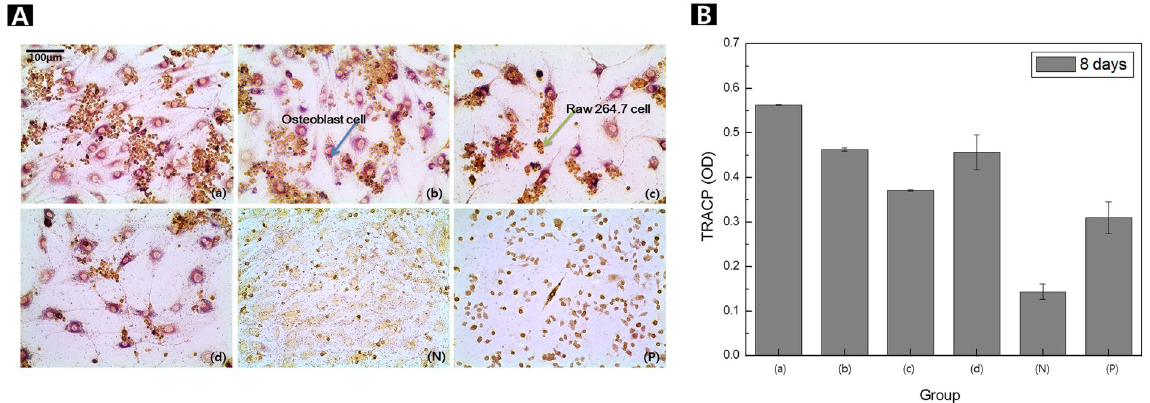
Figure 7. TRAP staining assay results ( A ) and TRACP activity ( B ) of osteoclast cells after co-cultured cell growth for 8 days (a) after anodization, (b) Ca deposition post anodization, (c) hydrothermal treatment at 120 °C, and (d) hydrothermal treatment at 150